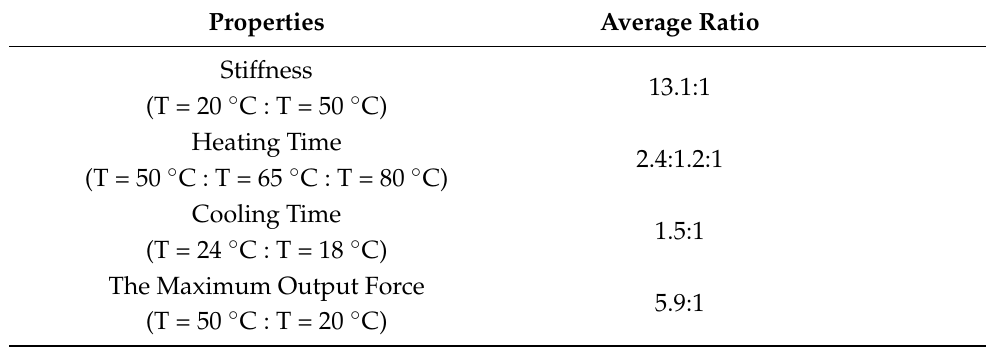
Figure 9. The demonstration of object gripping. ( a ) The gripper comprised of two actuators at initial state (T = 20 ◦ C, P = 0 MPa). ( b ) Gripper displaced to approach the object. ( c ) Pressure and temperature of the input fluid are increased (T = 50 ◦ C, P = 0.2 MPa) to facilitate the bending of the gripper. ( d ) The bending of the gripper is utilized for grasping the object firmly. ( e ) The input fluid’s temperature and pressure are reduced to 20 ◦ C, and 0 MPa and the object is lifted off the surface. The grasping of the object ( ≈ 100 g) using the gripper is shown in Movie S4. Table 2. The table of average